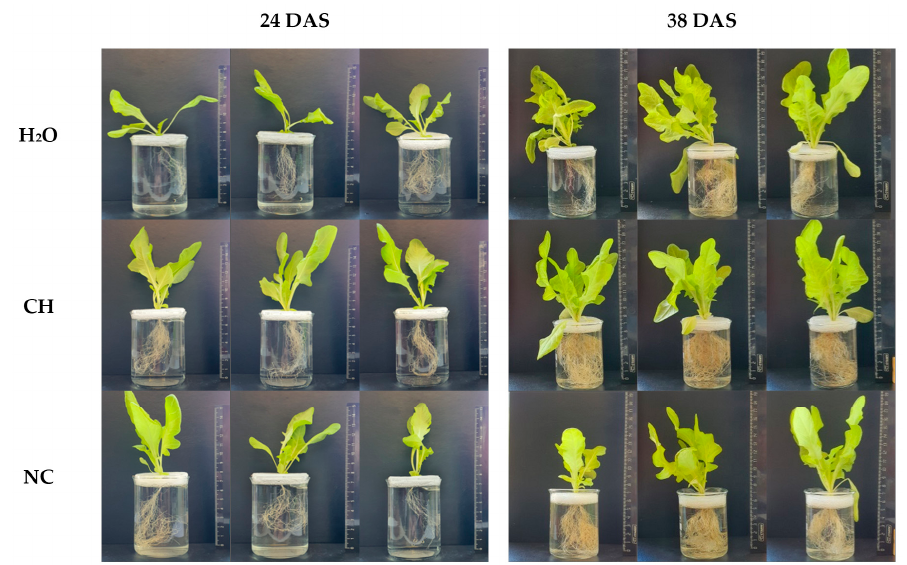
and 38th DAS. CH concentration, 0.1 mg/mL (dilution ratio 1:250); dilution ratio of NC solution, Figure 2. Influence of seed priming on development of shoots and roots of lettuce plants at the 24th